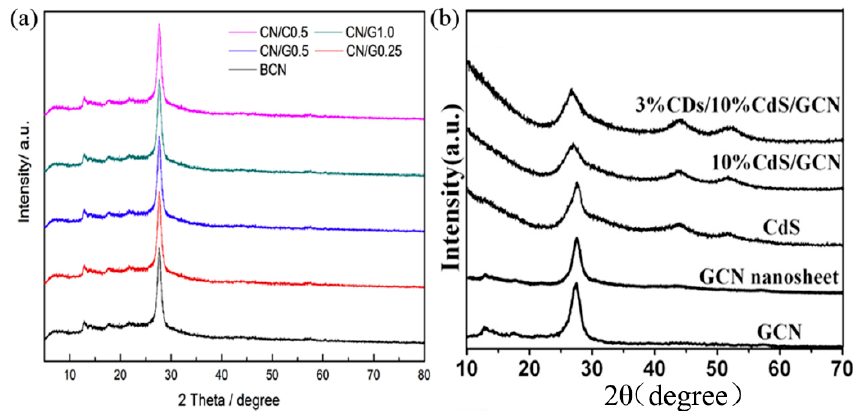
Figure 8. XRD patterns of ( a ) BCN, CN / G0.25, CN / G0.5, CN / G1.0 and CN / C0.5, ( b ) pure